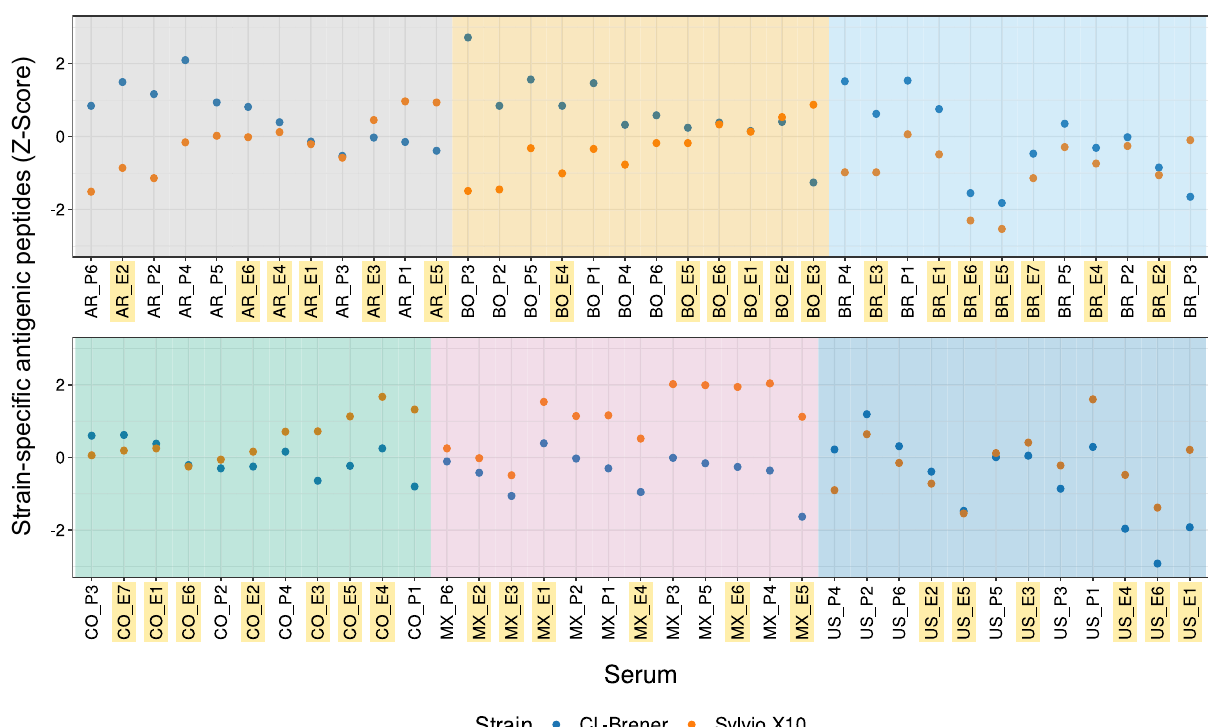
Fig. 5 | Comparison of strain-speci fi c antigenicity across subjects. Counts of eachsubject ’ sstrain-speci fi creactivepeptides(thosepresentinonlyonestrainand with a signal above the antigenicity threshold) were standardised using Z -scores. Standardisation was necessary because CL-Brener and Sylvio X10 strains have dif- ferent numbers of encoded proteins (see Methods). Z -scores above 0 and below 0 represent the higher and lower relative numbers of strain-speci fi c reactive